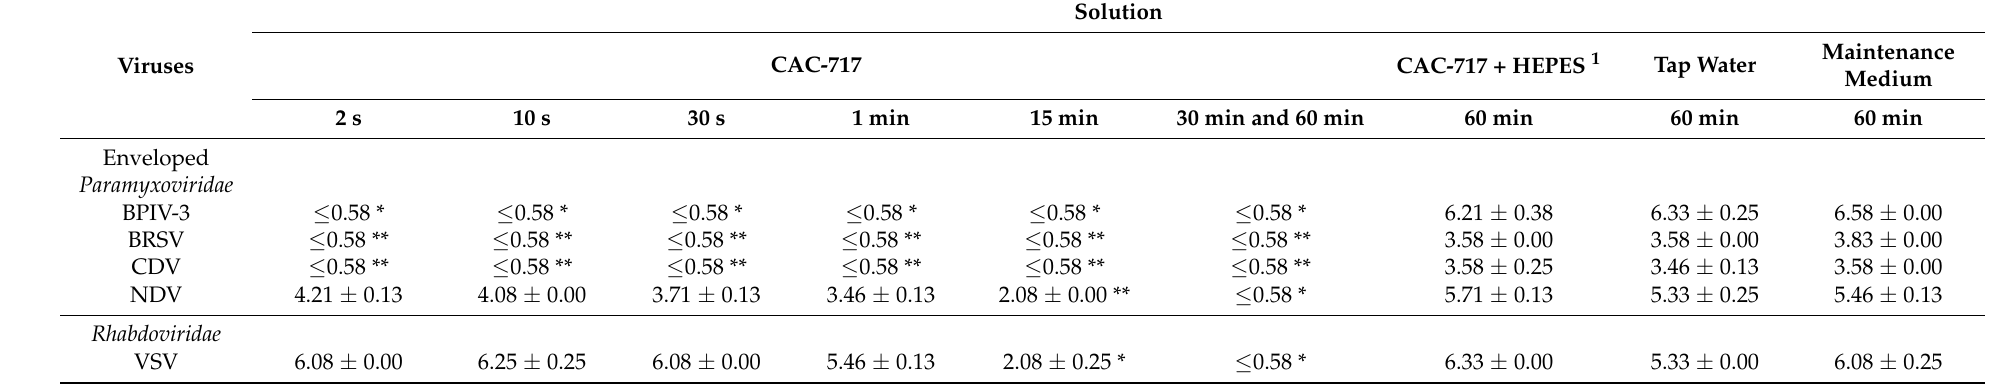
Table 3. Virucidal effects of CAC-717 on various RNA viruses. Viral titer is shown as log 10 TCID 50 /25 µ L (mean ± SE). Values are representative values from two separate